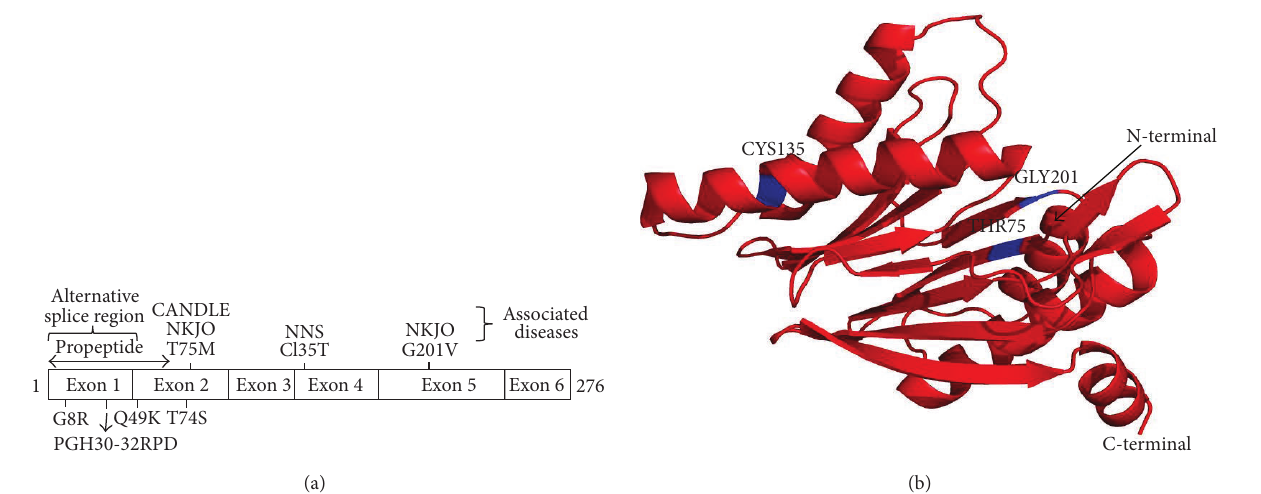
Figure 7: Schematic diagram of PSMB8 showing the location of known polymorphisms. (a) Diagram of PSMB8 showing exon organization (drawn to relative scale), location of alternative spliced region, propeptide region that is removed in the mature form of the protein, location of disease causing polymorphisms’, and location of other known polymorphisms. (b) Tertiary structure of 𝛽 5i (PSMB8) showing polymorphisms (shown in blue) associated with diseases. Structure created using PyMol